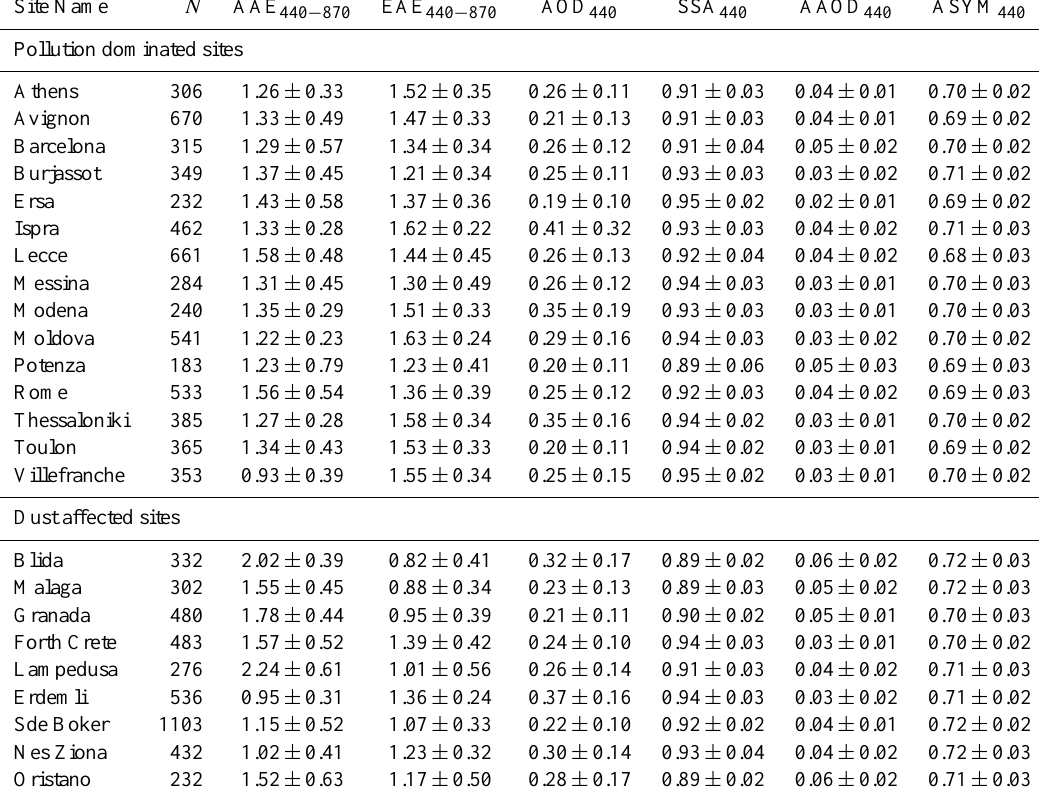
Table 2. Summertime averaged optical properties of (level 2) of Mediterranean AERONET sites used in this study. N represents the number of level 2 observation days during summer season used in analyses. The subscripts of parameters name show wavelength in